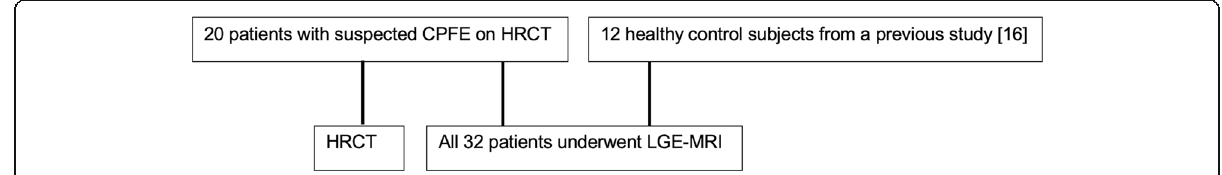
Fig. 1 Flowchart of patients and controls. CPFE, Combined pulmonary fibrosis emphysema; HRCT, High-resolution computed tomography; LGE- MRI, Late gadolinium-enhanced magnetic resonance